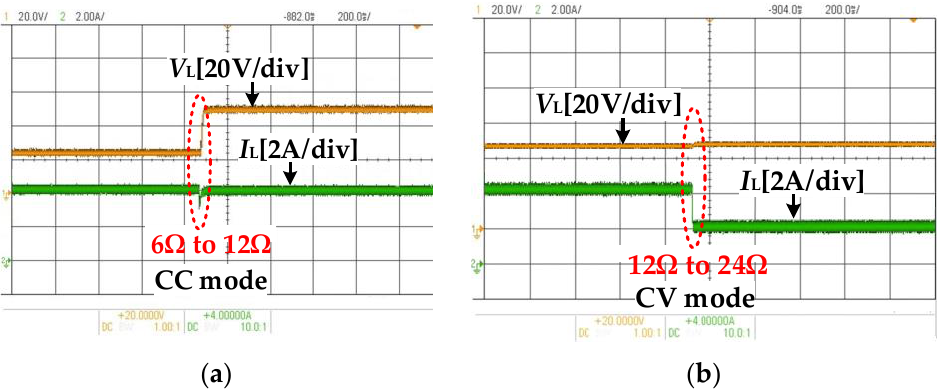
Figure 21. Dynamic performance of the proposed WPT system. ( a ) In CC mode, when the load changes from 6 to 12 Ω; ( b ) in CV mode, when the load changes from 12 to 24 Ω.